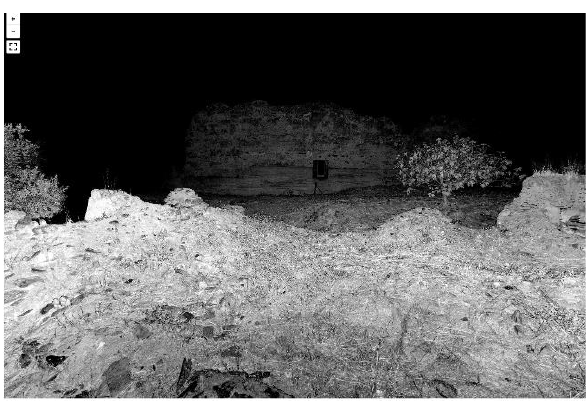
Figure 11. Interactive Panoramas based on TLS